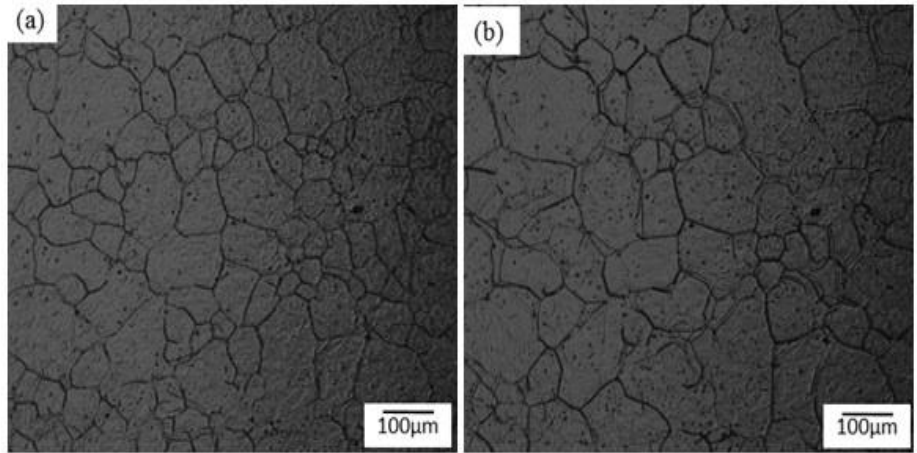
Figure 4. Grain size of comercial SS400 ( a ) at the beginning of austenatization and ( b ) after 20 min.